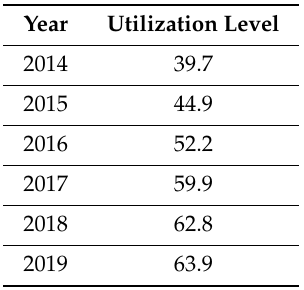
Table 4. Utilization Level of older people by